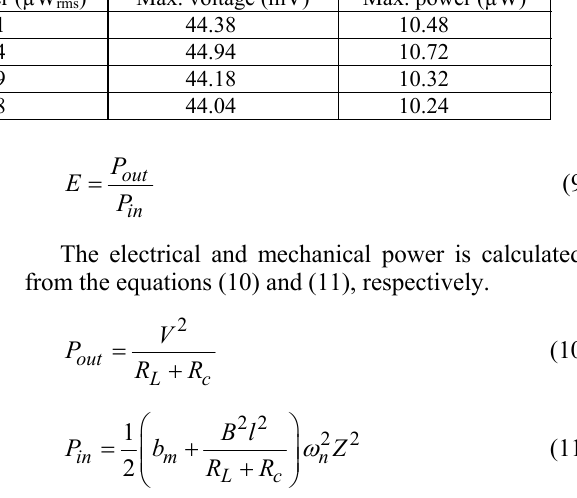
Table 3. Comparison of calculation analysis results in different modes Frequency (Hz)